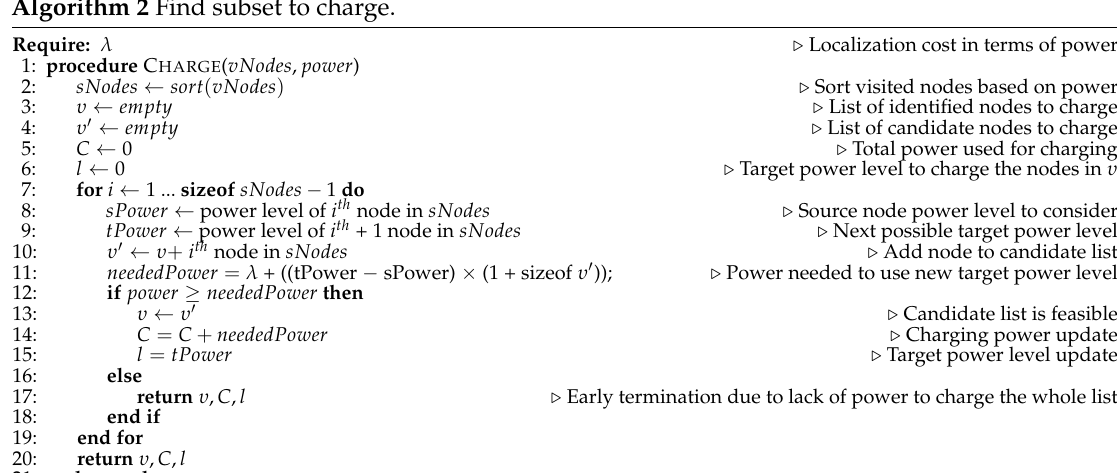
Algorithm 2 Find subset to